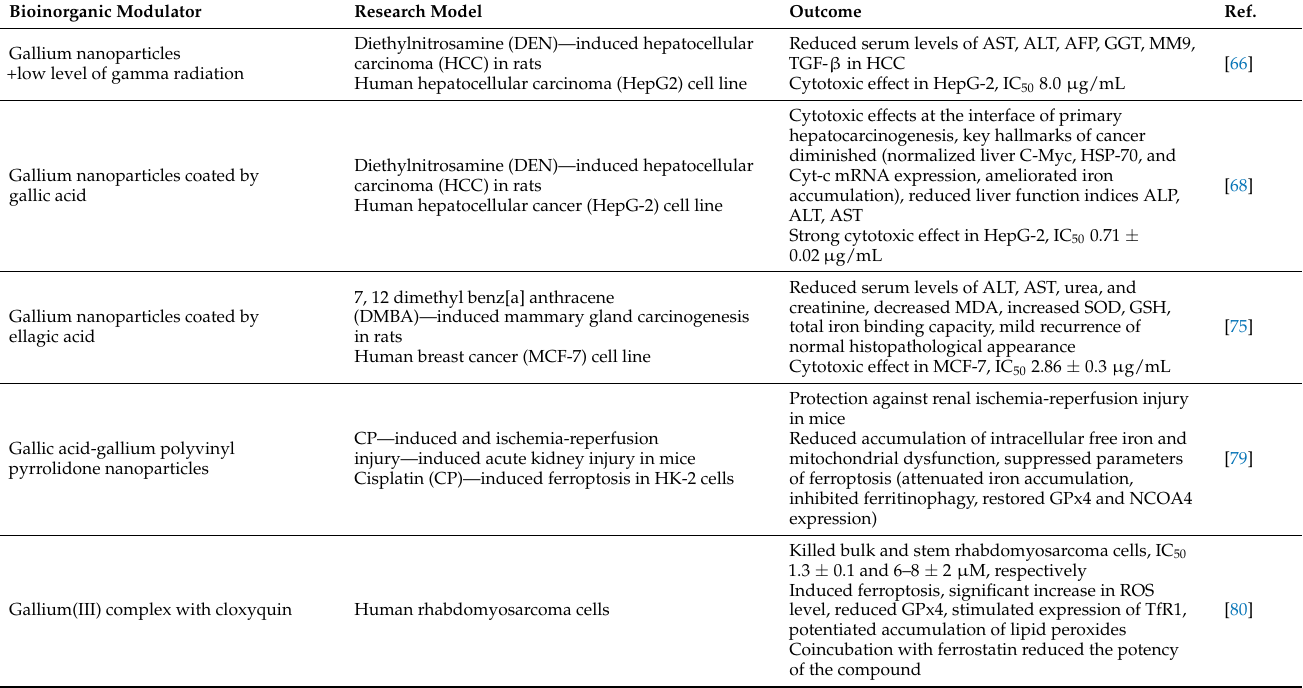
Table 1. Recapitulation of the gallium-based compounds and their modulatory effect on ferroptosis- related cell survival and